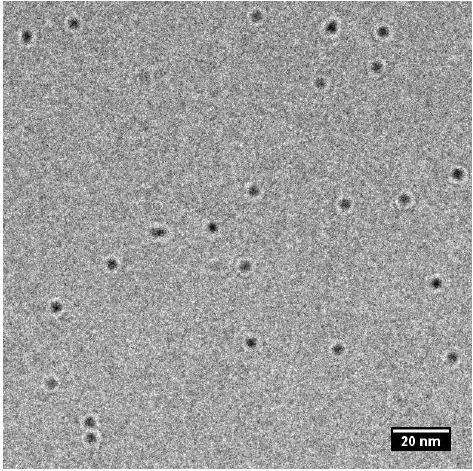
Figure 2. Transmission Electron Microscopy (TEM) picture of CdTe QDs.